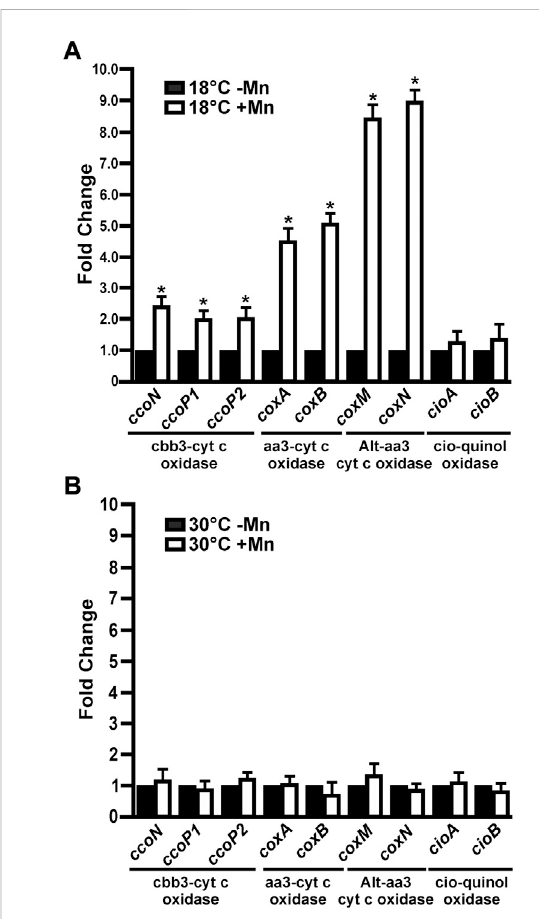
FIGURE 4 Expression of MOB-449 terminal oxidases genes under bio fi lm conditions. MOB-449 bio fi lms were grown in Lept or Lept + Mn at 18 ° C (A) or 30 ° C (B) and subjected to RT-qPCR assays to analyze the expression of ccoN , ccoP1 , ccoP2 , coxA , coxB , coxM , coxN , cioA and cioB . The 15S gene was used as internal control for the calculation of relative gene expression. White bars indicate the expression levels of the genes in Lept + Mn relative to the expression levels in Lept (Black bars). Values are the means of three biological replicates with three technical replicates each. Error bars indicate standard deviation. Data were analyzed by Student ’ s t-test and asterisks indicate signi fi cant differences ( p < 0.05) between samples grown with the addition or not of Mn(II).